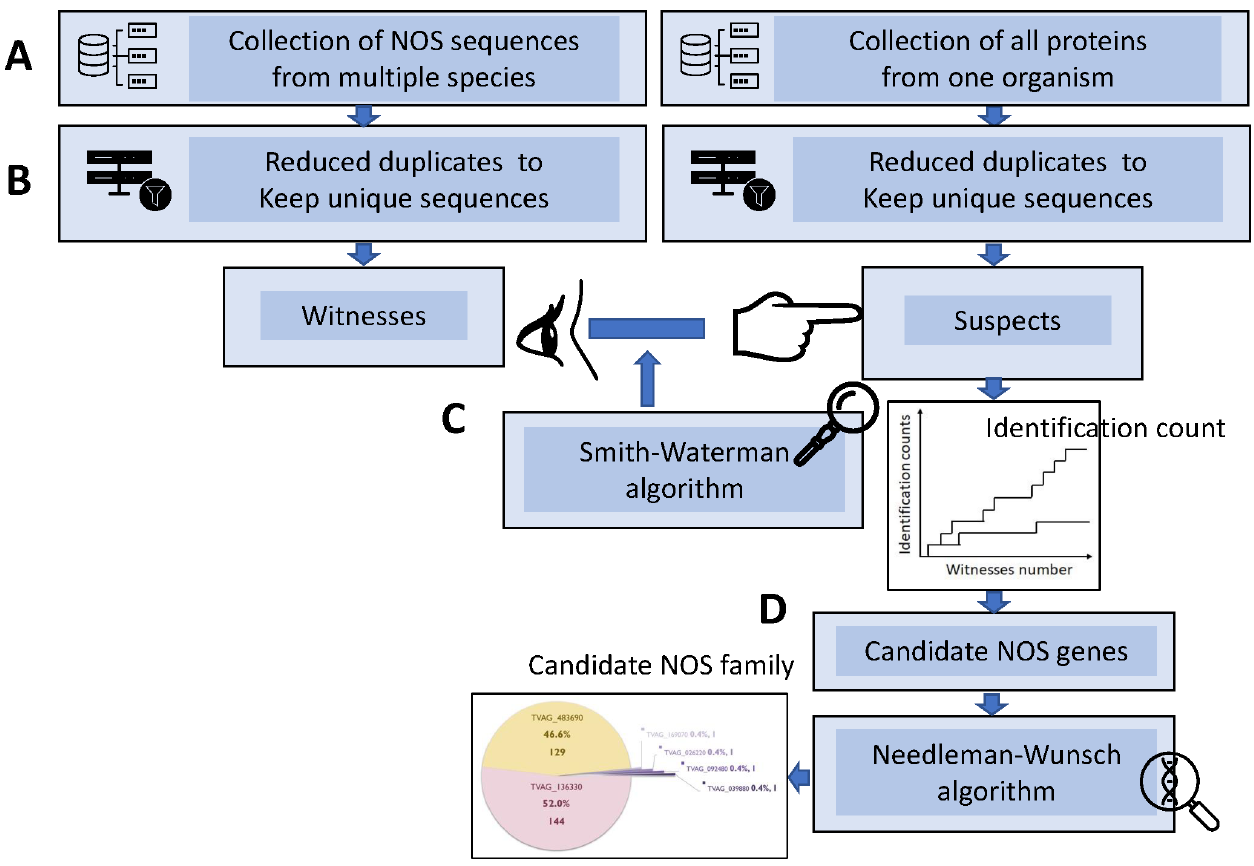
Figure 1. Flowchart illustrating the strategy and procedure of identifying TV NOS genes in this study. ( A ) Protein sequences of non-TV organisms were retrieved from NCBI database to serve as witnesses, while sequences of all TV proteins were retrieved to serve as suspects. ( B ) Duplicates of the retrieved sequences were removed to keep unique sequence for each witness or suspect. ( C ) Smith–Waterman algorithm were performed as the first step of the hybrid alignment method to identify suspects with a score greater than 100 bits by using non-TV NOSs as query sequences. ( D ) Needleman–Wunsch algorithm was performed as the second step of the hybrid alignment method to determine the final candidates with high witness-to-suspect